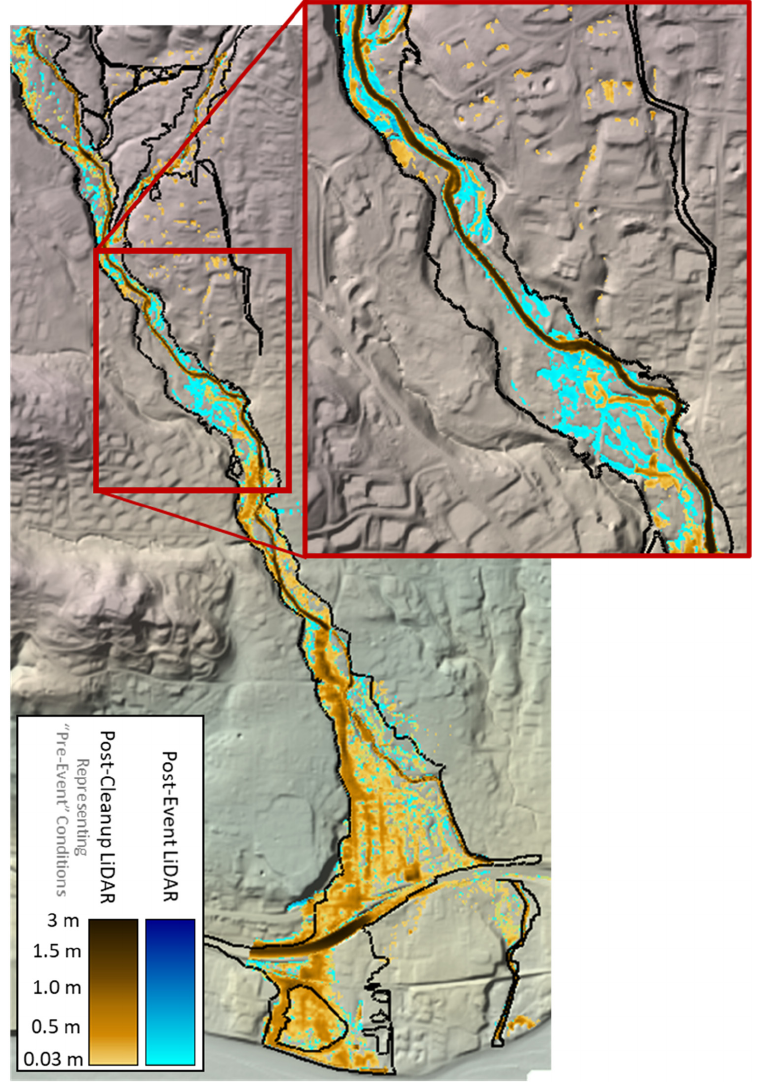
Figure 6. Montecito model with the post ‐ clean up terrain (representing the pre ‐ event terrain) from Figure 2 and a simulation with the same fluid parameters and a terrain collected closer to the event, which captured some of the pre ‐ cleanup deposition. The model performed better with terrain that included the event.